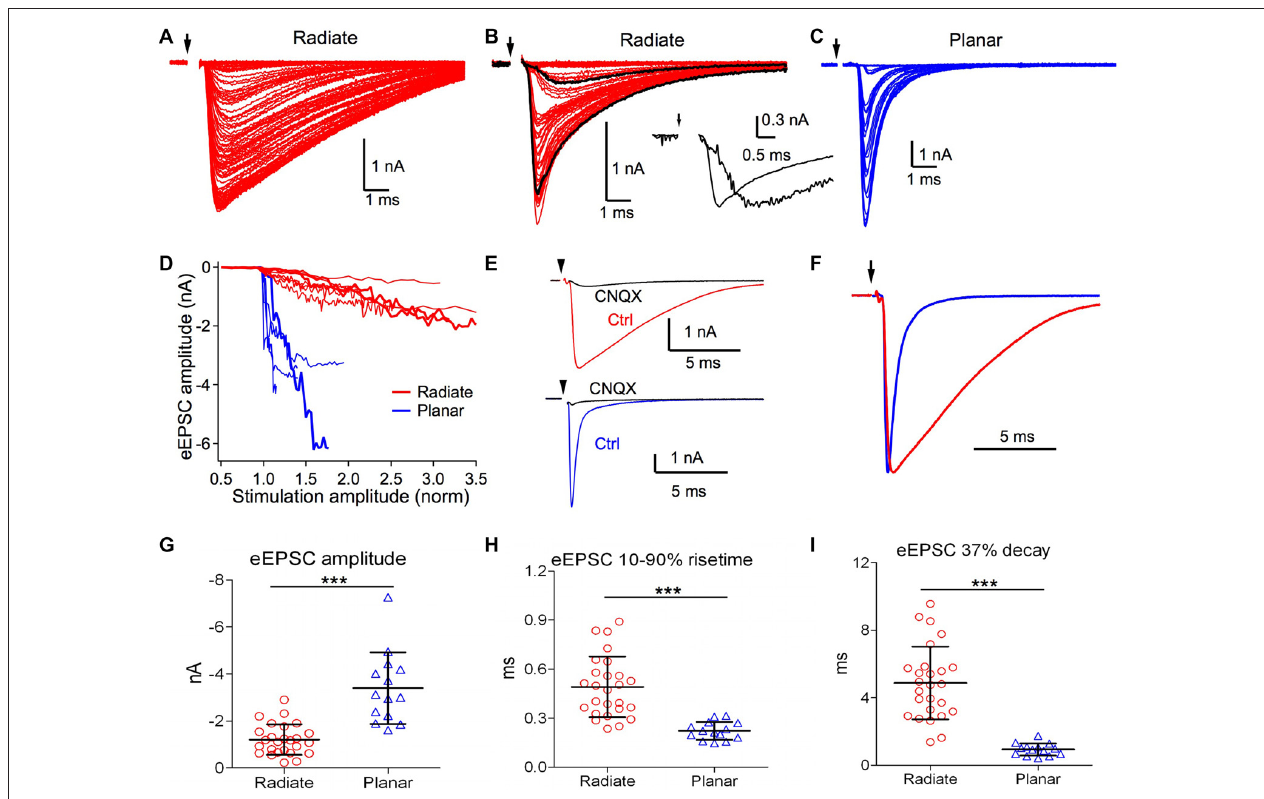
FIGURE 4 | Radiate neurons receive weaker and slower evoked synaptic inputs than planar neurons. (A,B) Example eEPSCs of radiate neurons (red) with graded amplitudes driven by stimuli with progressively increased strength. Arrow: onset of electric stimulation. Notice in (B) that a fast eEPSC component was recruited beyond a certain stimulus strength that changed the shape of eEPSCs. Black traces in (B) , an example slow eEPSC evoked by weak stimulation and a fast eEPSC evoked by strong stimulation. Inset: the two black traces were normalized to the peak amplitude to show the temporal differences in eEPSCs driven by stimuli at different strength. (C) Example eEPSCs of a planar neuron (blue) driven by stimuli with progressively increased strength. The increase in eEPSC amplitude occurred over a narrow stimulus range, and grew in a stepwise fashion. Note the scale differences in eEPSC amplitudes among (A–C) . (D) Summary plot of eEPSC amplitudes vs. normalized stimulation amplitudes in radiate and planar neurons. Each line represents one individual neuron. Thick red lines mark the example radiate neurons in (A,B) , and the thick blue line marks the example planar neuron in (C) . The stimulation amplitude was normalized to the threshold stimulus current used